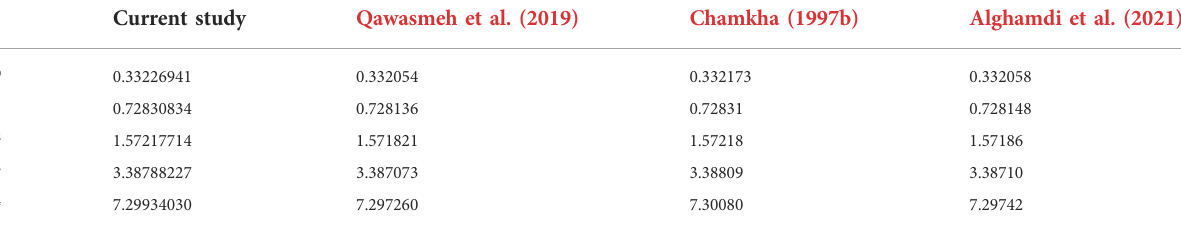
TABLE3 Amountof − θ 9 ( 0 ) forcertainPrandtlnumberwith φ 1 (cid:1) 0 , φ 2 (cid:1) 0 , m (cid:1) 0 , Ec (cid:1) 0 ε (cid:1) 1 , α ( x ) (cid:1) 0 , γ ( x ) (cid:1) 0 , R (cid:1) 0forNewtonianliquidwhen β → ∞ . Pr Current study Qawasmeh et al. (2019) Chamkha (1997b) Alghamdi et al.